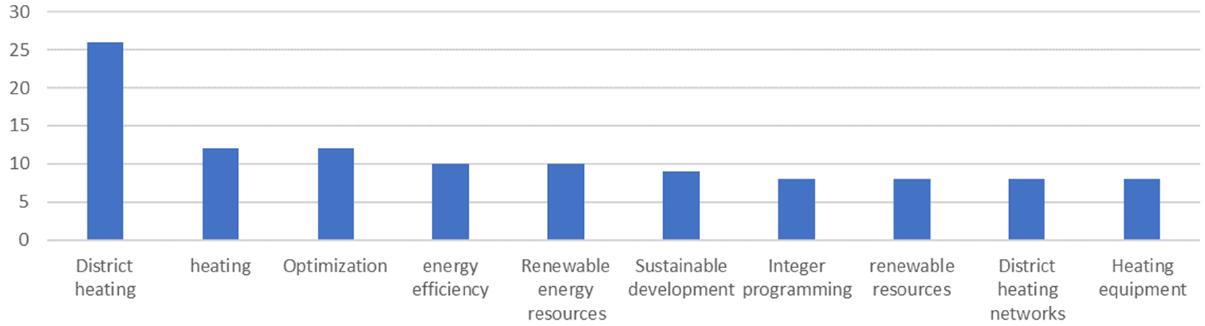
Figure 14. City systems—most frequent keywords (horizontal axis) and the number of articles (vertical axis).